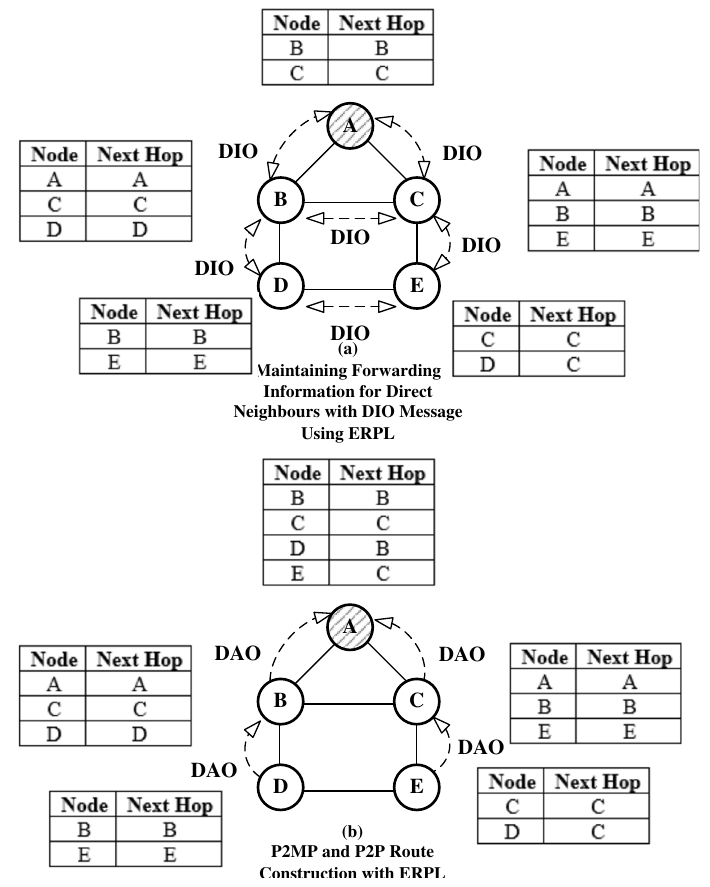
Figure 3. P2MP and P2P Route Construction in Enhanced RPL (ERPL).